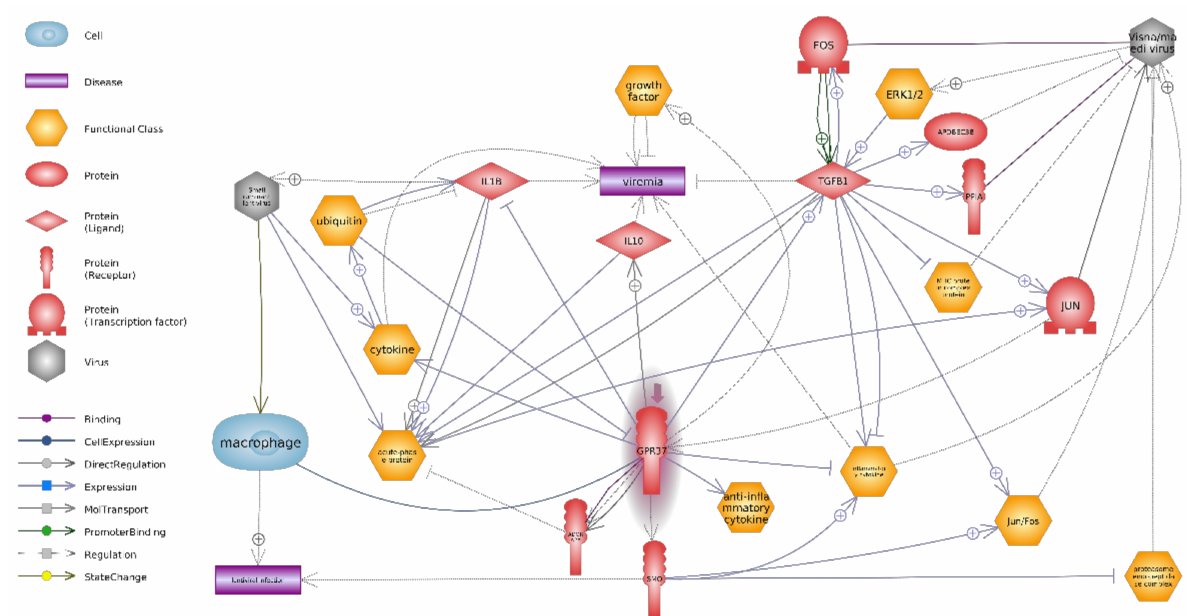
Figure 3. Involvement of GPR37 in processes related to the cellular response to infection with small ruminant lentiviruses/visna-medi virus in goats. Pink highlights downregulation; GPR37—G protein-coupled receptor 37; FOS-Fos proto-oncogene, (AP-1 transcription factor subunit) is a protein coding gene. These genes encode leucine zipper proteins that can dimerize with proteins of the JUN family, thereby forming the AP-1 transcription factor complex. The interaction between Fos and Jun targets the Tat visna virus and promotes its replication in monocytes and macrophages after their differentiation. Fos-Jun activation can influence the activation of many cellular genes; this could intensely affect cell and viral growth and thus play a role in the pathogenesis of the visna virus; TGFB1— TGF β 1 gene encodes a secreted ligand of the TGF-beta (transforming growth factor-beta) superfamily of proteins. This protein regulates cell proliferation, differentiation, and growth, and can modulate the expression and activation of other growth factors, including interferon gamma and tumor necrosis factor alpha [31]. IL1B-interleukin 1 β ; IL-10 interleukin 10; APOBEC3B—apolipoprotein B mRNA editing enzyme catalytic polypeptide-like 3. The antiviral APOBEC3 protein is packaged into the forming virions and limits replication by causing mutations in viral cDNA. PPIA (aliases CYPA, Cyclophilin A)—the PPIA gene encodes a member of the peptidyl-prolyl cis-trans isomerase (PPIase) family. In goat SRLV, Vif can exploit the host cellular PPIA protein as a co-factor for caprine APOBEC3 degradation. [32]; SMO (Smoothened). The SMO gene encodes a member of the Frizzled family of G protein-coupled receptors, which is connected with the hedgehog (Hh) signaling pathway. In humans, SMO inhibits infection by HIV-1 and limits the spread of HIV-1 infection by suppressing the formation of viral DNA